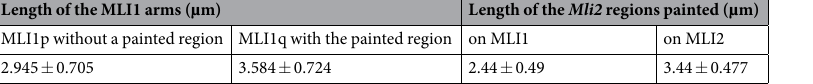
painting of M. lignano chromosomes with probe Mli2 revealed in the q-arm of MLI1 (MLI1q) a region homolo- gous to a very substantial part of MLI2 (Fig. 2a,c,e). Morphometry showed that MLI2 was somewhat longer than the Mli2 painted region in MLI1q (Table 1). Furthermore, no intensive signal that was similar to the FISH signal in the pericentromeric region of MLI2 was observed within the painted region of MLI1q. We also note that no cluster of telomeric repeats was previously observed at the proximal end of the painted region (i.e. there were no interstitial telomeric sequences in MLI1, see ref. 14). This suggests that both clusters of pericentromeric and telomeric repeats were probably lost from the painted region of MLI1q. FISH with Mli3_4 revealed specific signals in two pairs of small chromosomes (identified as MLI3 and MLI4; Fig. 2e, red) and in the region of MLI1 that remained unpainted with Mli2 (Fig. 2e, green). Like FISH with Mli2 , FISH with Mli3_4 produced some signal in all pericentromeric regions (Fig. 2e, orange). No additional regions with increased FISH signals were revealed in the regions painted with Mli3_4 . Simultaneous FISH with Mli2 and Mli3_4 painted chromosome MLI1 completely (Fig. 2e), with some colocalization in the pericentromeric regions (Fig. 2e, orange). FISH with the 28S rDNA (green) and the Mli2 (red) probes revealed a 28S rDNA cluster at the ends of the p-arm of MLI1 (Fig. 2a). Moreover, on prometaphase chromosomes we could identify a cluster of 28S rDNA at the end of the q-arm of MLI3 (see also ref. 14), which might thus allow us to distinguish this chromosome from MLI4.